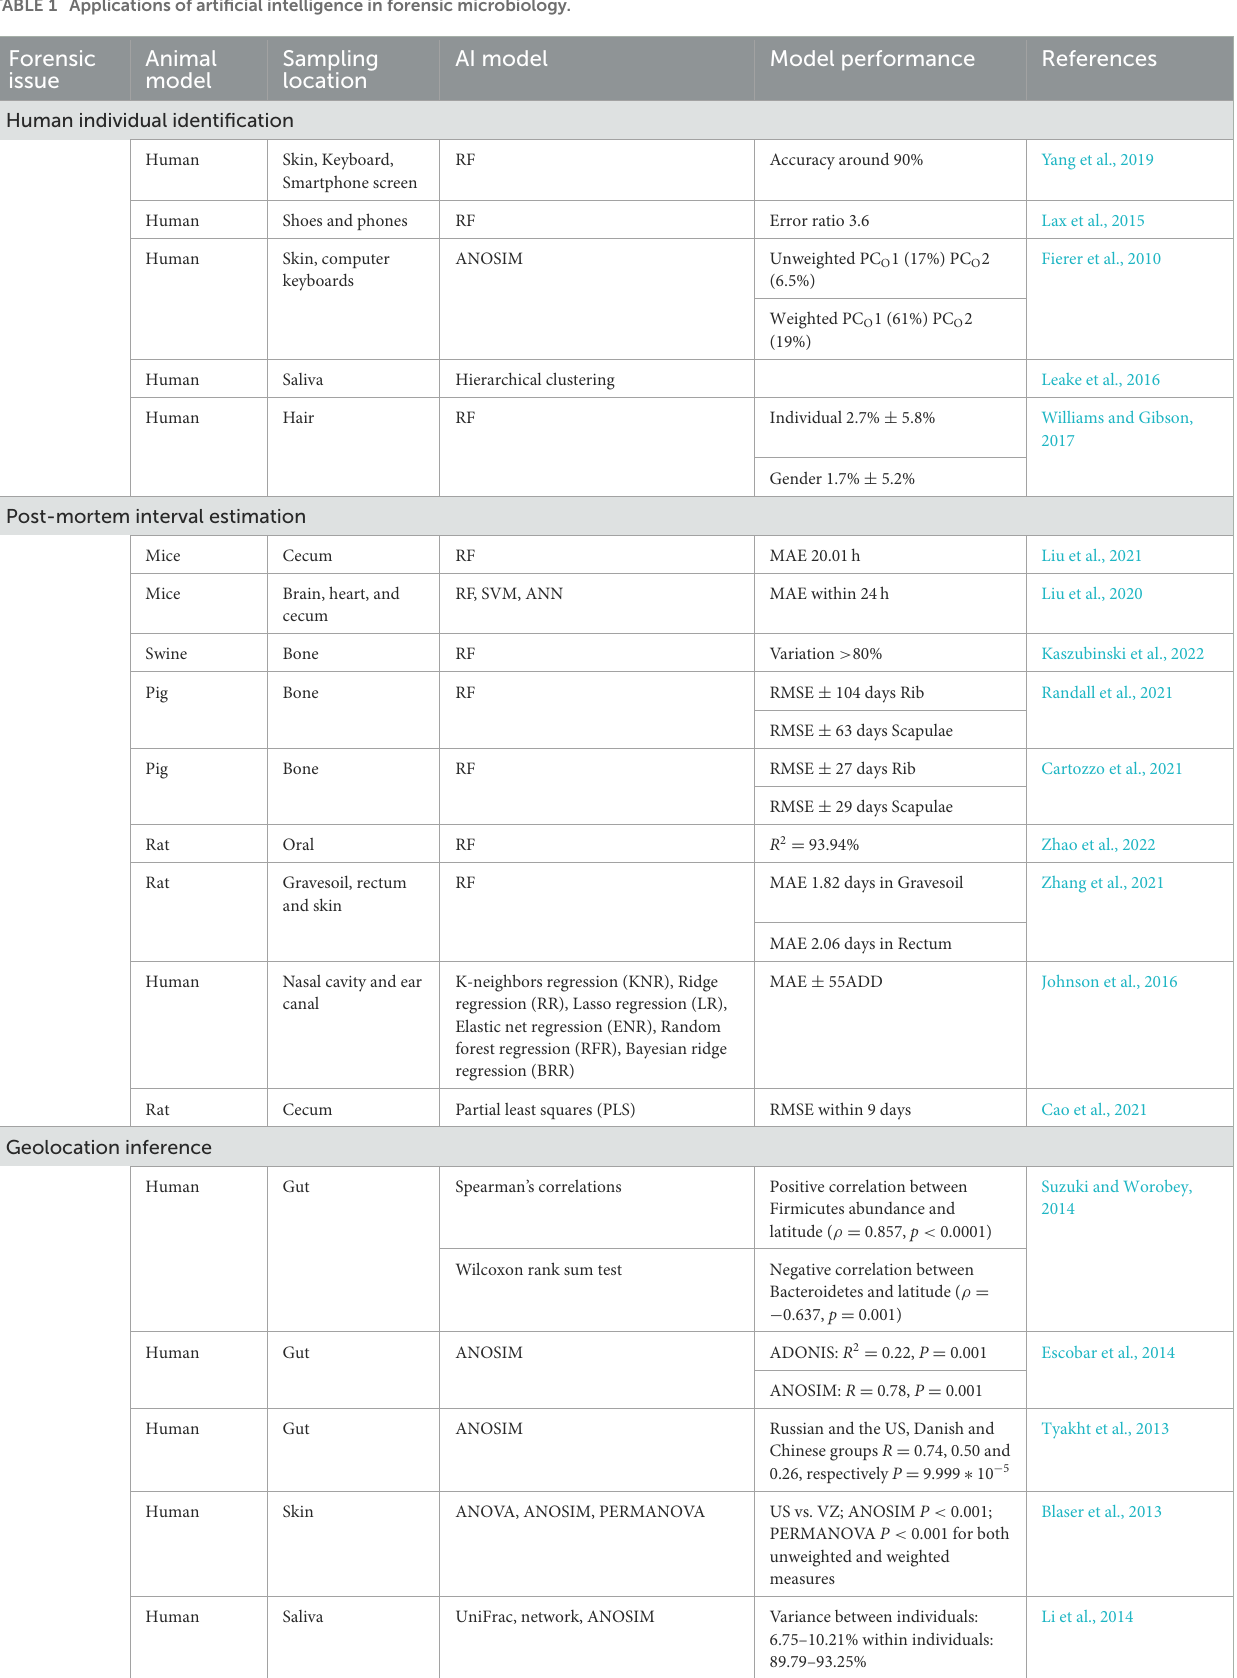
TABLE 1 Applications of artificial intelligence in forensic